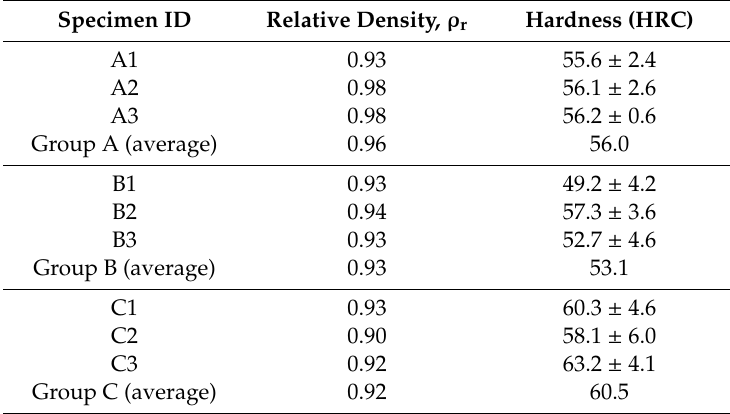
Table 2. Density and hardness of SLM AISI 420 specimens of various build directions.